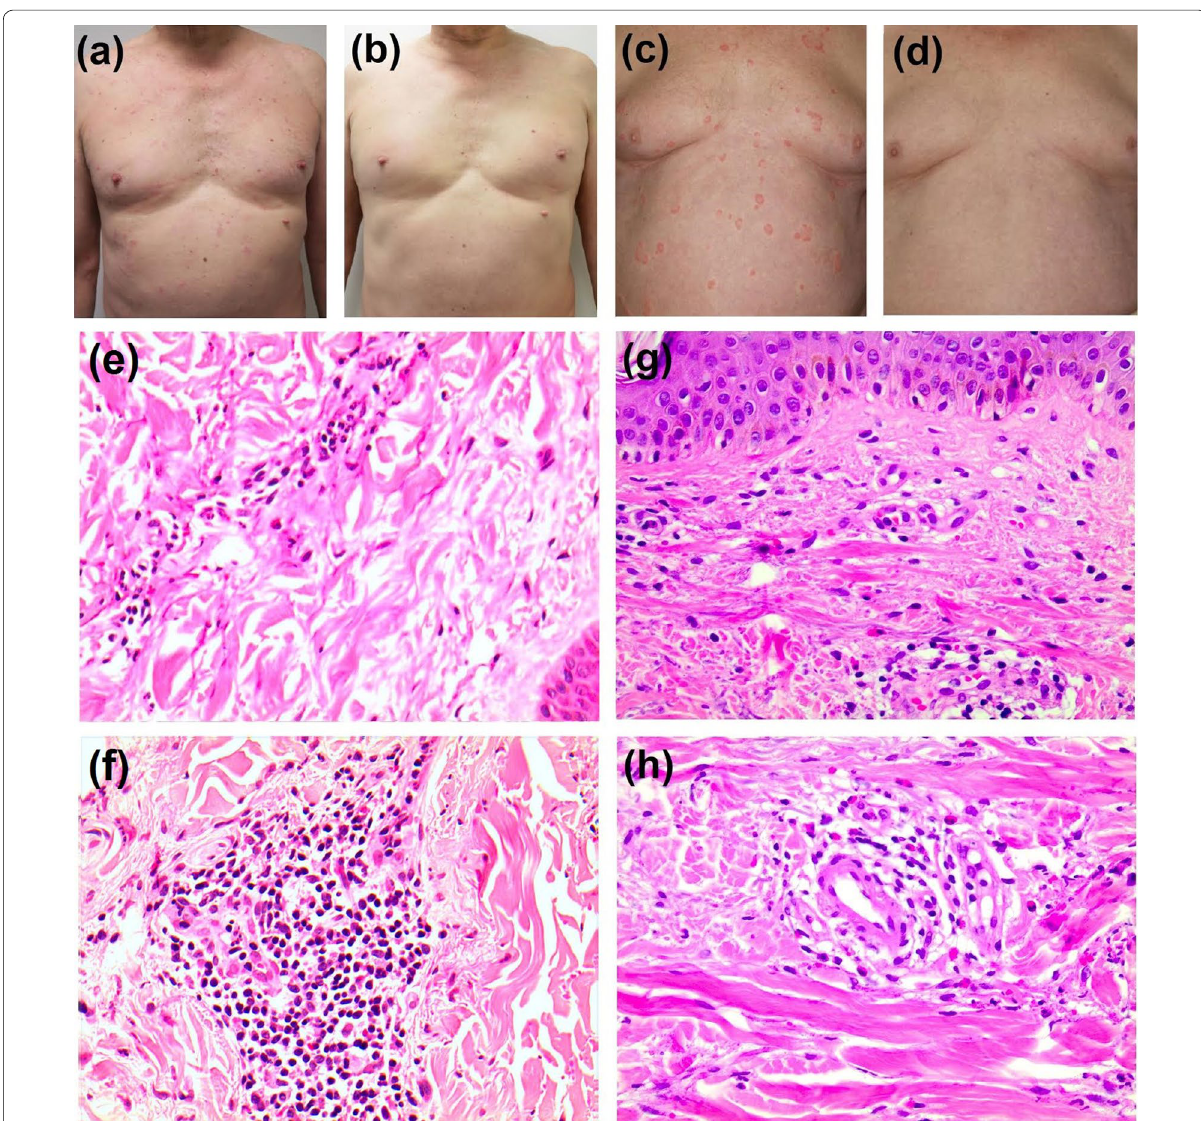
Fig. 1 Patient 1—clinical photography of patient before ( a ) and after ( b ) treatment, histopathological sections of skin showing leukocytoclastic vasculitis with mild erythrocyte extravasation ( e , f ). Patient 2—clinical photography of patient before ( c ) and after ( d ) treatment, and histopathological sections of skin showing leukocytoclastic vasculitis with perivascular neutrophilic infiltrate and erythrocyte extravasation around small dermal vessels ( g ) and fibrinoid deposits within a vessel wall ( h